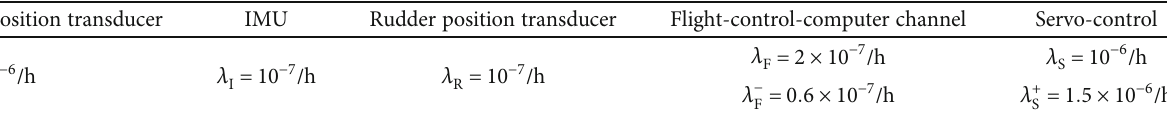
Table 1: Component failure rates of the rudder control system.